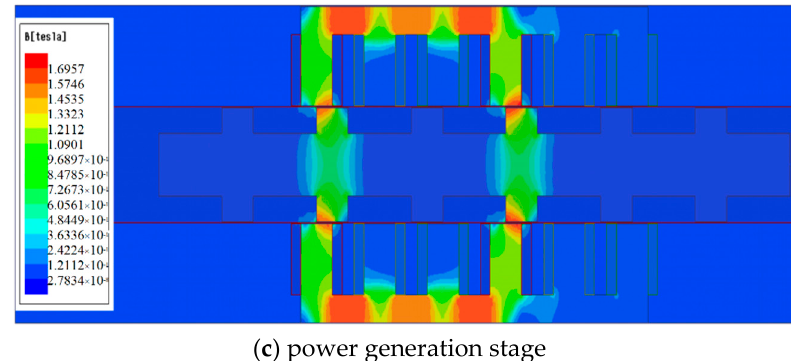
Figure 4. Magnetic density distribution cloud image of typical position in one cycle operation of DLSRG. ( a ) The generator is in the excitation phase; ( b ) The generator is in the critical state; ( c ) The generator is in the power generation stage.